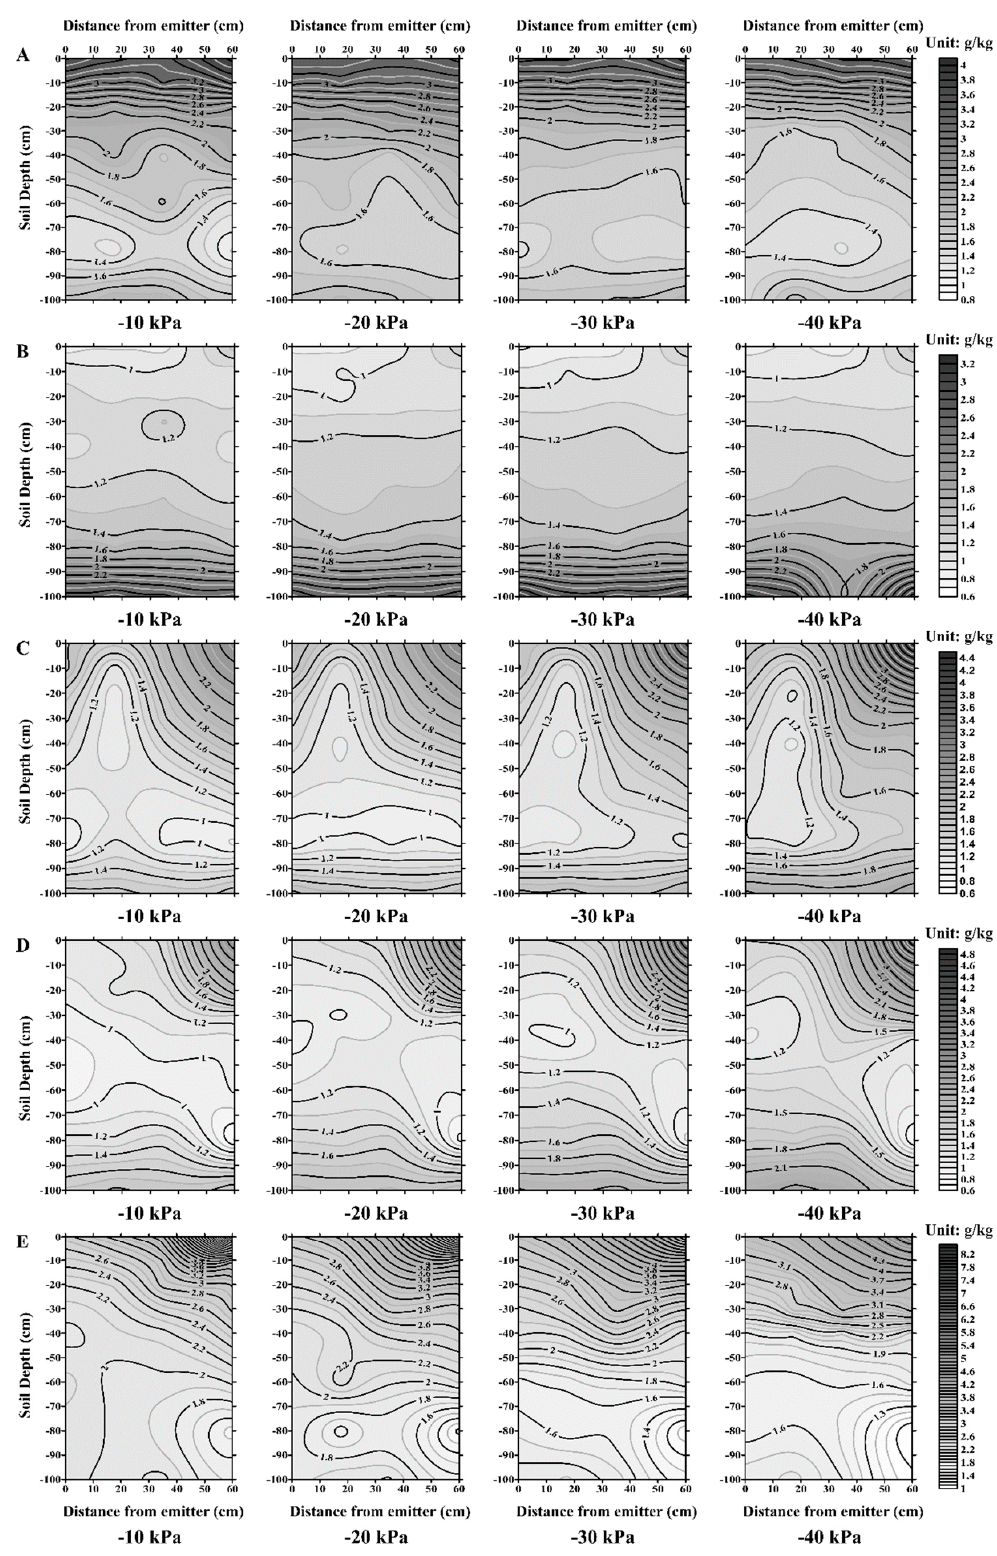
Figure 8. Spatial distribution of soil salt (g · kg − 1 ) along the vertical transect that is perpendicular to the drip line ( A ) before spring irrigation, ( B ) before sowing, ( C ) before the irrigation at the jointing stage, ( D ) after the irrigation at the jointing stage, and ( E ) after harvest, for all treatments in 2015.